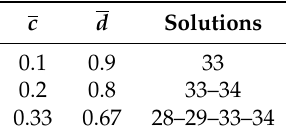
Table 11. Sensitivity analysis to variations in the thresholds c and d .